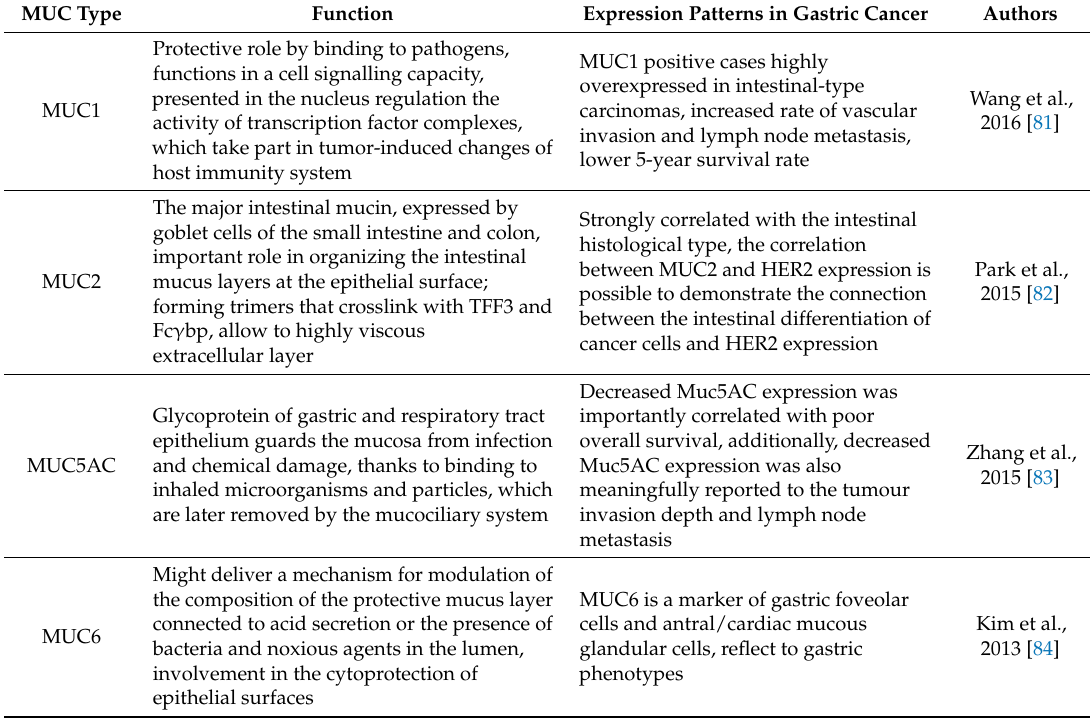
Table 1. Mucins and their impact on patient’s survival with gastric